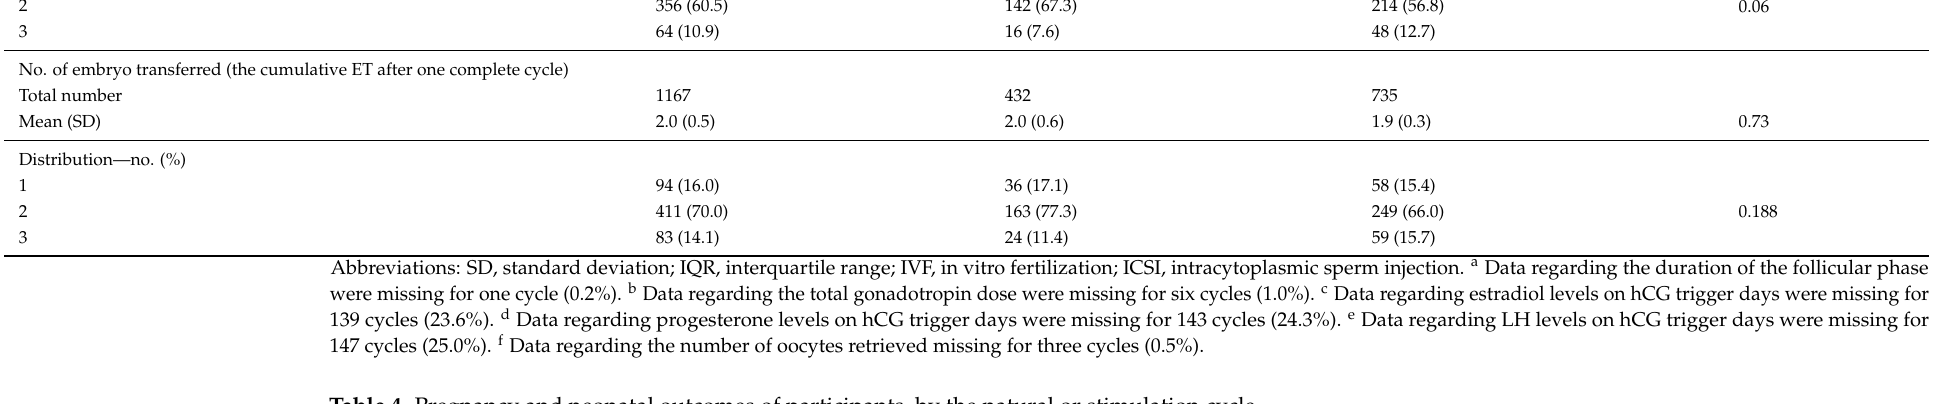
Table 4. Pregnancy and neonatal outcomes of participants, by the natural or stimulation